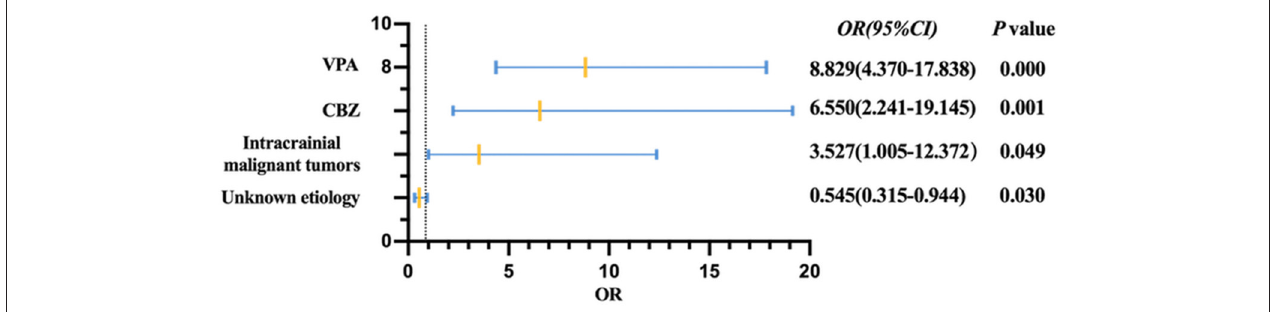
TABLE 4 | One-year seizure-free rate of successive ASM regimens at last follow-up. Type of ASM Number of patients taking the ASM regimen